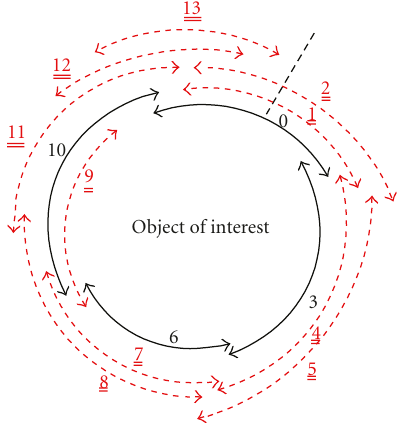
Figure 5: Example of N mod ρ min > 0.